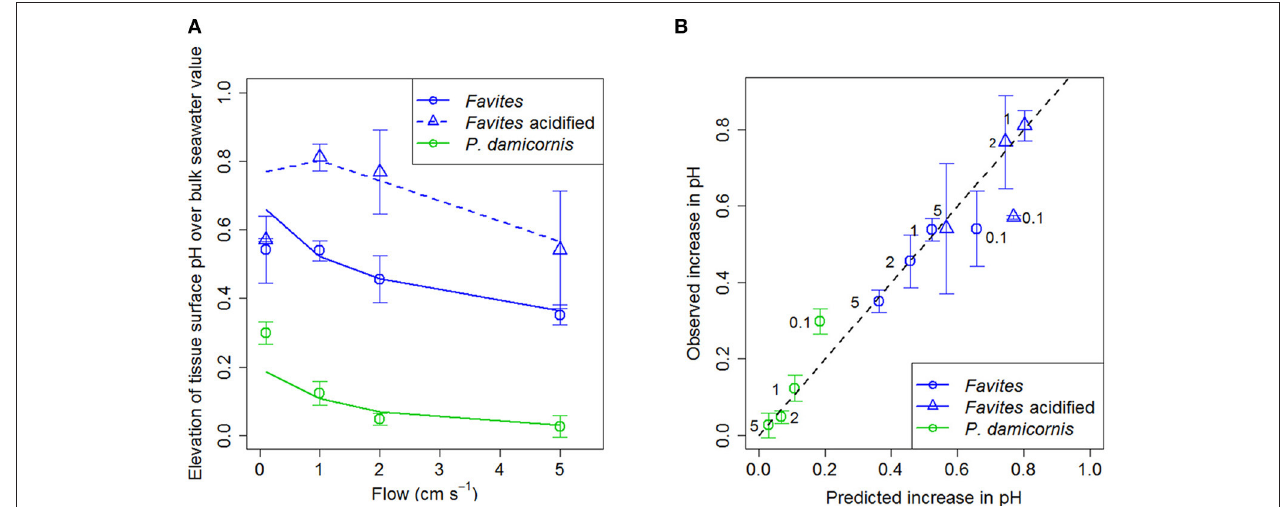
FIGURE 2 | (A) Elevation of tissue surface pH relative to bulk seawater (tissue surface pH – bulk seawater pH) at various flows (cm s − 1 ) for Favites (blue circles), Favites under acidified conditions (blue triangles), and P. damicornis (green circles). Symbols with error bars represent the mean ± 1.96 * SE ( n = 4 –6). Lines represent model predictions. Bulk seawater had a pH SWS of 8.2 ( ± 0.04 SD; n = 10 ) and TA = 2325 µ mol kg − for ambient conditions and a pH SWS of 7.8 ( ± 0.08 SD; n = 10 ) and TA = 2325 µ mol kg − 1 for acidified conditions. (B) Observed (measured with microsensor) vs. predicted (from model) values of elevation of tissue surface pH relative to bulk seawater at various flows (cm s − 1 ) for Favites (blue circles), Favites under acidified conditions (blue triangles), and P. damicornis (green circles). Black numbers next to points are the flow velocities. Black dashed line represents the unity line where predicted values equal observed values.